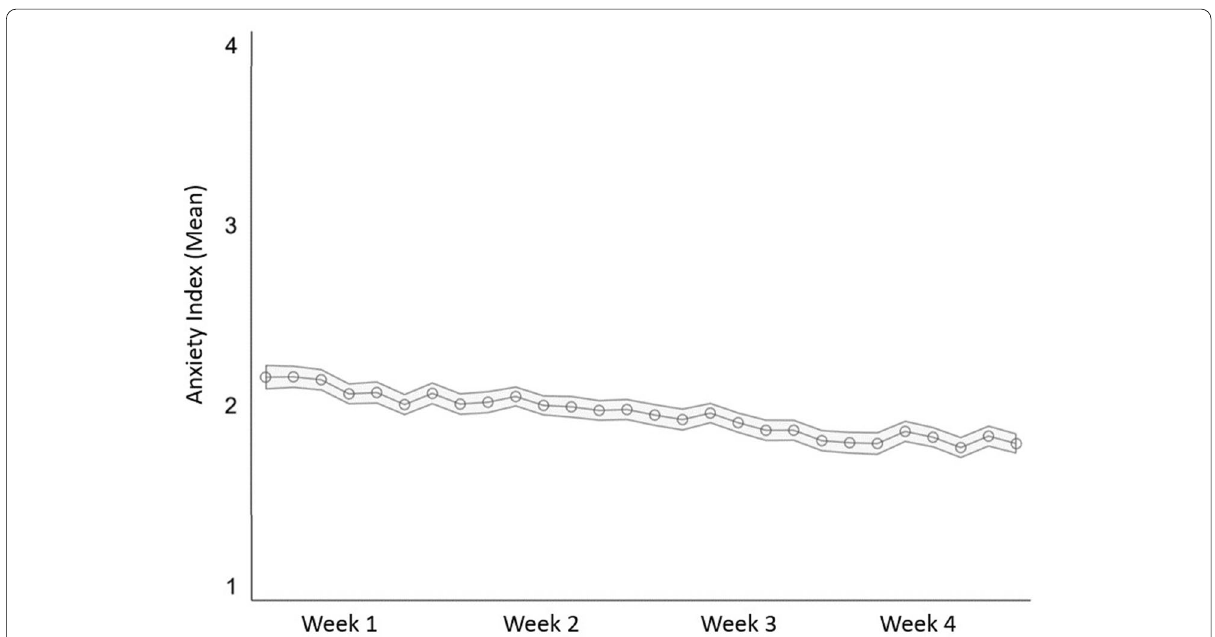
Fig. 2 Mean anxiety levels across the first four MCS data collection week. The calculated anxiety scale ranges between 1 and 4. Light gray area represents 95% confidence